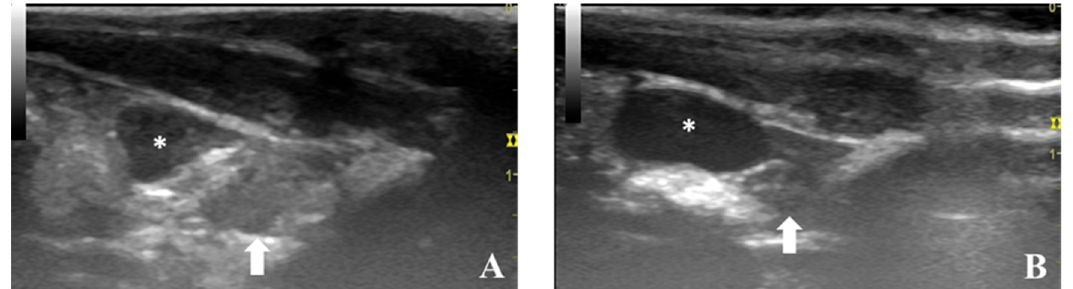
Figure 5. Longitudinal ultrasonographic scan of prostate from control animals ( A , B ). The dorsal prostate lobe (arrow) is observed dorsally to the neck of the urinary bladder (asterisk).